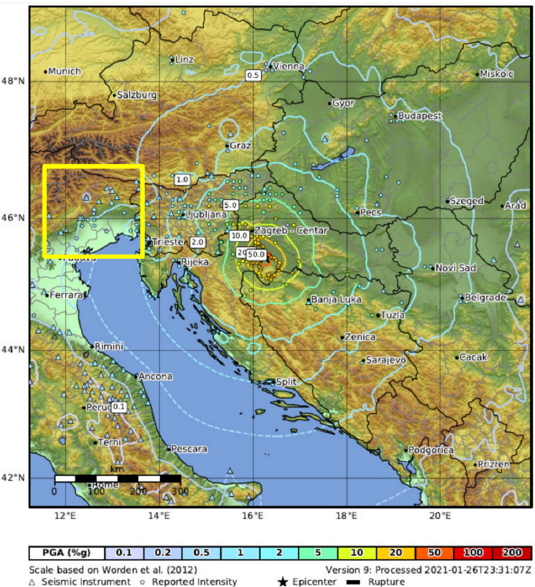
Figure 4. The peak ground acceleration map inferred from the USGS shake map (modified). In the yellow square, we marked the seismic station installed in northern Italy.